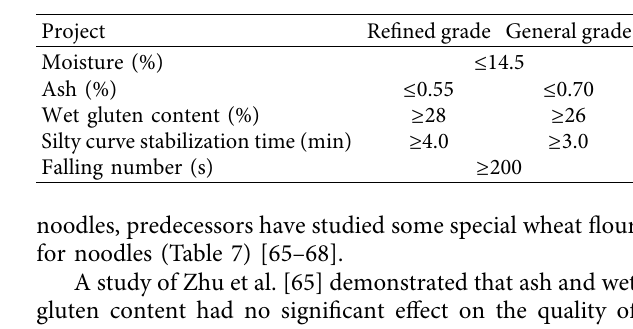
Table 6: Standard for wheat flour for